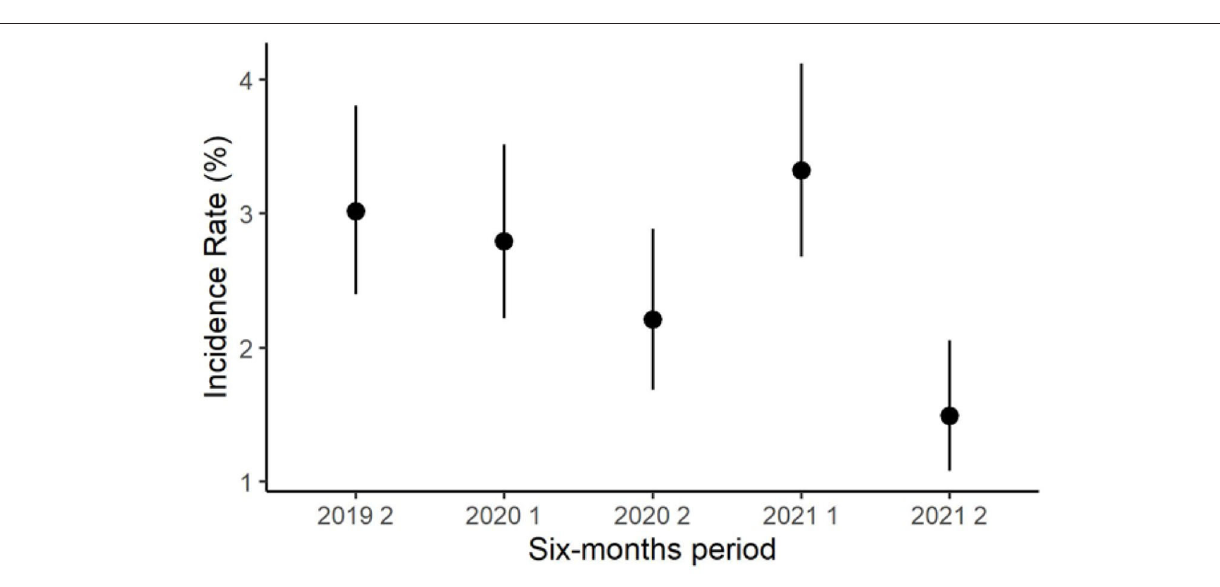
Frontiers in Veterinary Science |